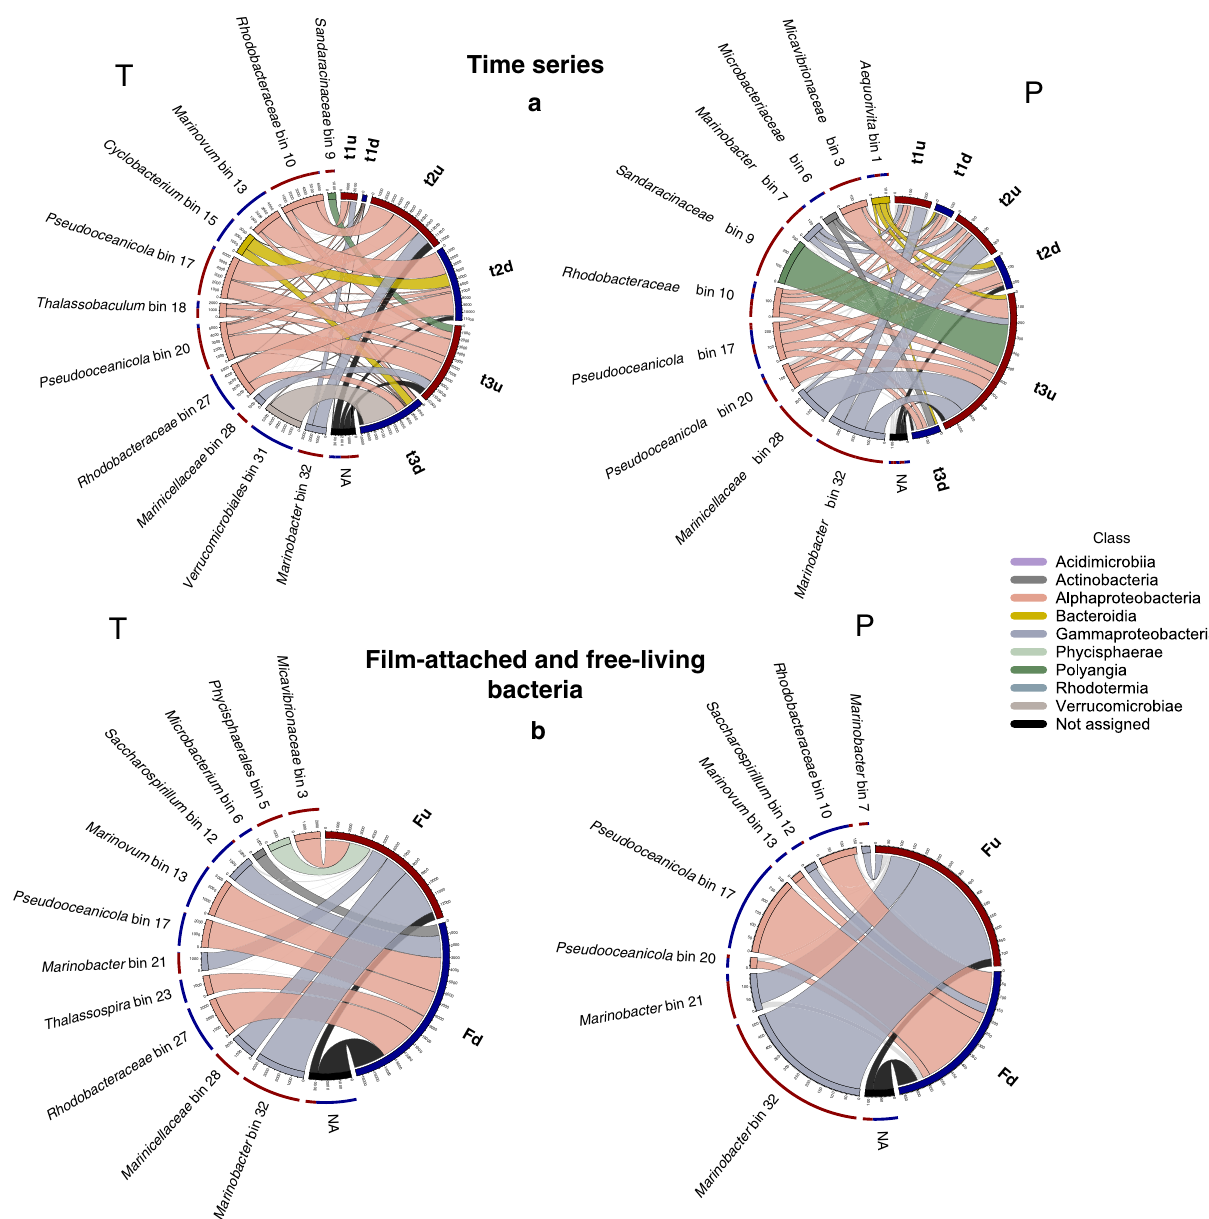
Fig. 4 Bin contribution to gene expression and protein biosynthesis. a The amount of signi fi cantly upregulated ( “ -u ” , red segment) and downregulated ( “ -d ” , blue segment) transcripts (T) and proteins (P) are shown for sampling time points (t1, t2, t3). b The amount of transcripts (T) and proteins (P) signi fi cantly upregulated in the fi lm-attached community/downregulated in the free-living community ( “ Fu ” , red segment) or downregulated in the fi lm- attached community/upregulated in the free-living community ( “ Fd ” , blue segment) are also shown. The average of at least two biological replicates were used to calculate transcript and protein fold changes. The amount of genes and proteins detected are represented by the size of each ribbon. Each color represents transcripts and proteins that belong to a certain bacterial class. The outer arc shows the amount of transcripts and proteins up/downregulated per bin (left side of each circle). Tick marks indicate numbers of transcripts and proteins up/downregulated per bin. NA represents genes that could not be allocated to any bin. Only bins that contributed with ≥ 1000 transcripts and ≥ 25 proteins are shown. Source data are provided as a Source Data fi